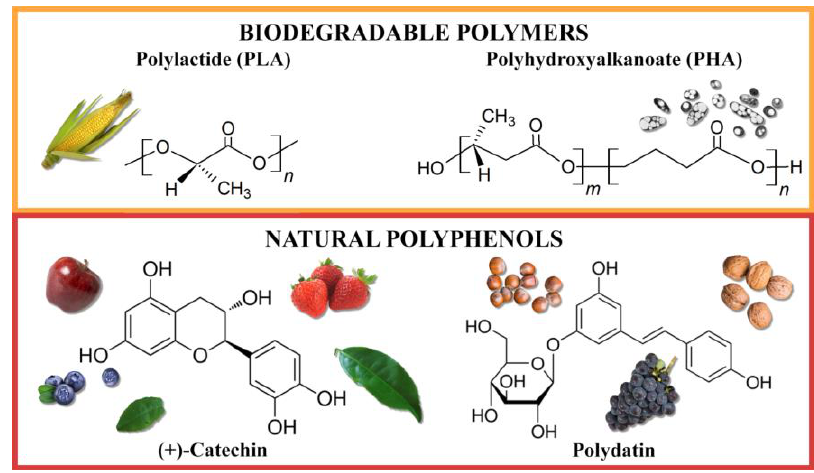
Figure 10. Structure and sources of biodegradable polymers and natural polyphenols.